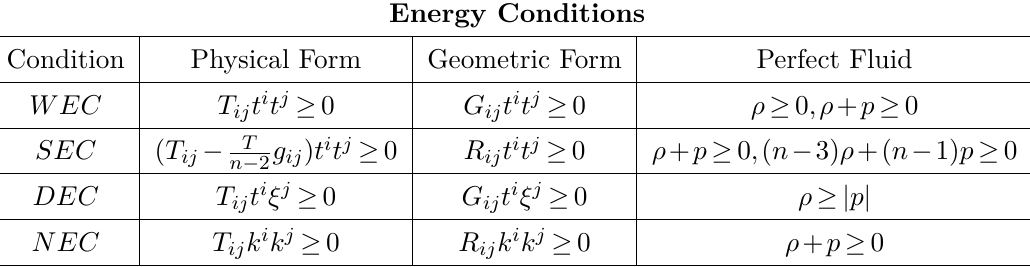
Table 3. Energy conditions.